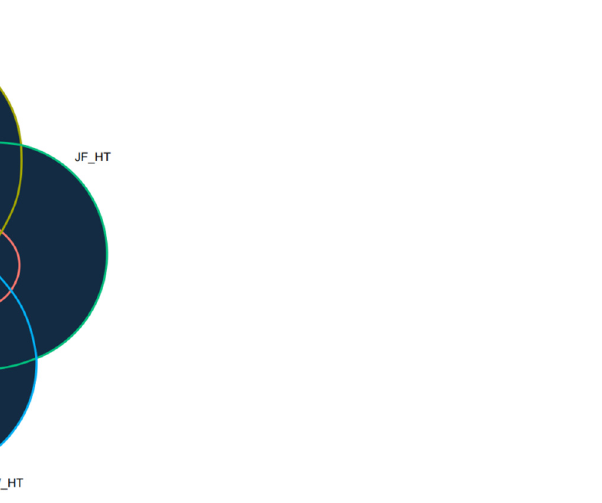
Figure 2. Venn diagram related to the attributes chosen by 30% of the panel to describe JF. Numbers inside the diagram represent the number of terms selected by the panel. In total, 25 terms were common to all the samples; 1, crunchy, was absent in JF DW and JF HT; and 1, fibrous, was absent only in JF HT.